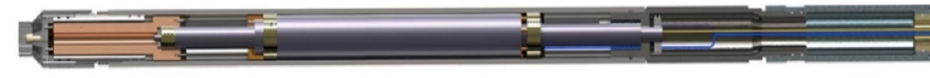
Figure 2. Structure of the oscillatory hammer driven by PMLM.